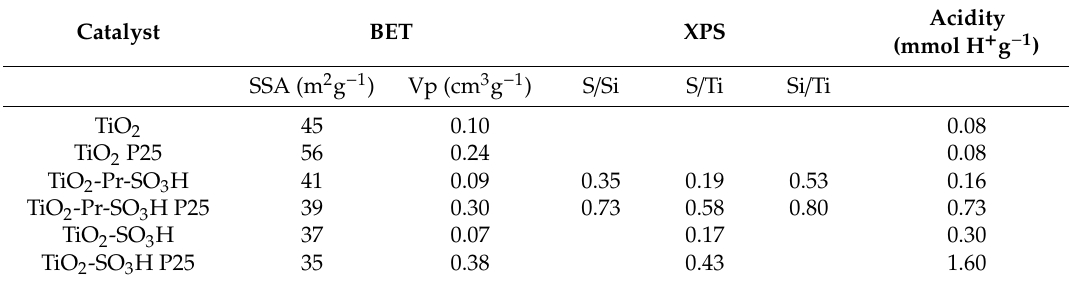
Table 1. Textural properties, XPS atomic ratio and acid capacity of each prepared material.